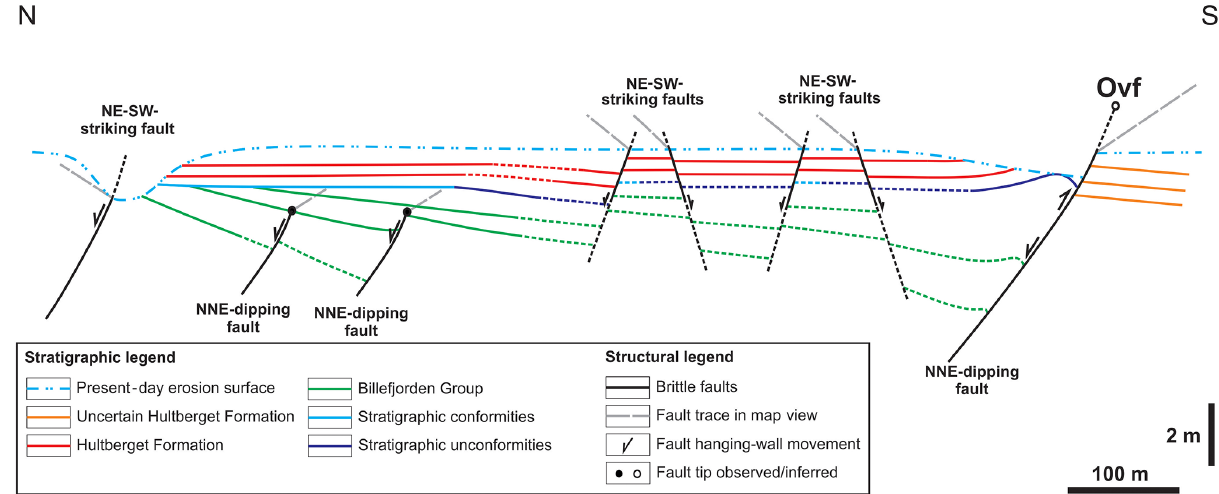
Figure 11. Approximately 1km long schematic N–S-oriented cross section of the studied outcrops in Odellfjellet. The section summarizes observations made along the riverbed and includes upwards dying-out NNE-dipping normal faults with Mississippian growth strata, abundant N–S- and NE–SW-striking normal faults with decimeter–meter-scale offsets, and the Overgangshytta fault (Ovf), a potential Mississippian NNE-dipping normal fault formed along steep, inherited, basement-seated, Neoproterozoic fabrics. The anticline in the hanging wall of the Overgangshytta fault suggests that the fault was inverted as a thrust during Cenozoic transpression. Note the southward change from unconformity (light blue) to conformity (dark blue) between sedimentary strata of the Billefjorden Group and Hultberget Formation.